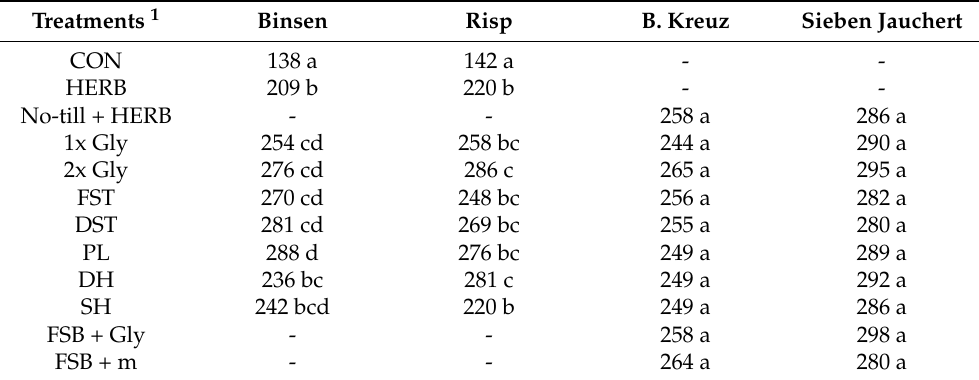
Table 7. Winter wheat density (plants m − 2 ) 120 DAS (Binsen, Risp, B. Kreuz and Sieben Jauchert). Means with the same letter are not significantly different according to HSD test at p ≤ 0.05. Levels of significance are shown behind the result for each experimental site separately.